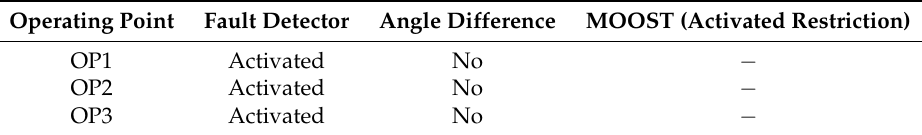
Table 8. Detailed ASS operation under different